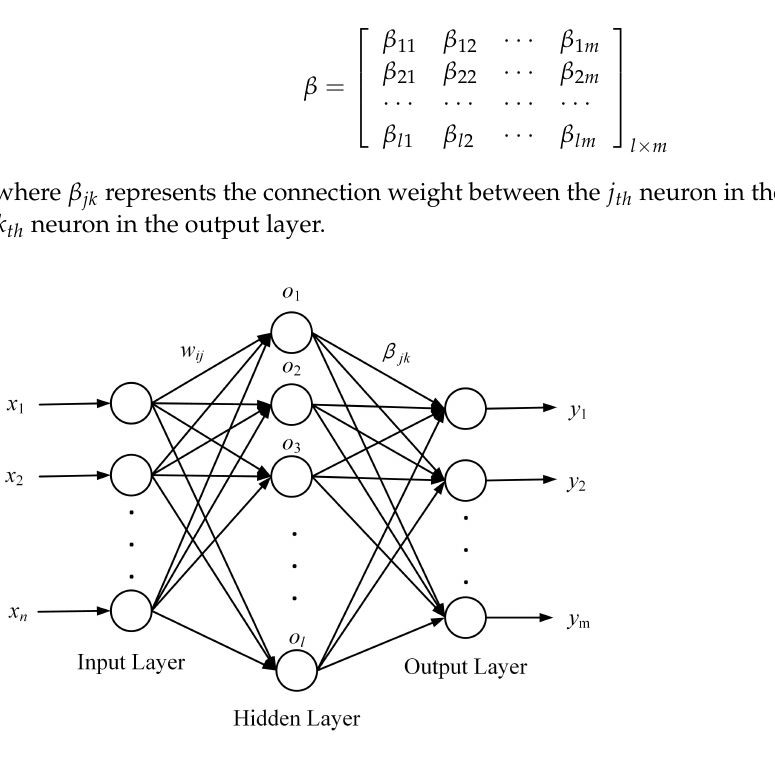
Figure 5. Typical single hidden layer neural network